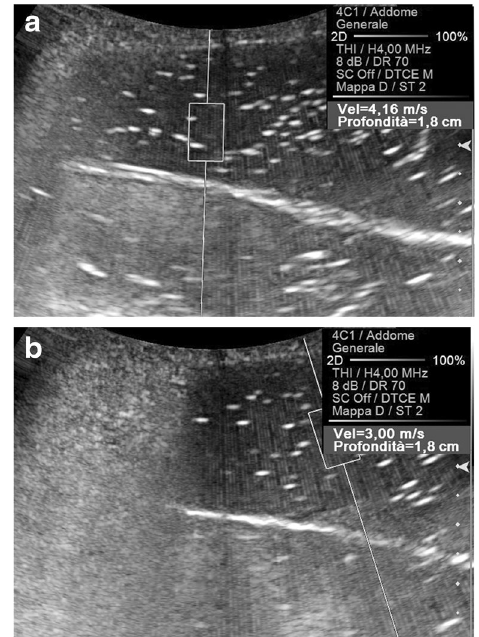
Fig. 6 Effect of the orientation of the ROI on the speed of propagation of the shear waves.A higher SWV value (4.16 vs. 3.00 m/s) is attributed to a given target (oil) with a ROI parallel ( a ) rather than oblique ( b ) to the main US